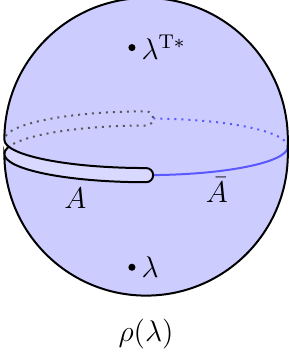
Figure 5. The density matrix (cid:26) ( (cid:21) ) for a subregion A may be prepared by taking the path integrals for j (cid:21) i and h (cid:21) j , and gluing along (cid:22) A , the complement of A .